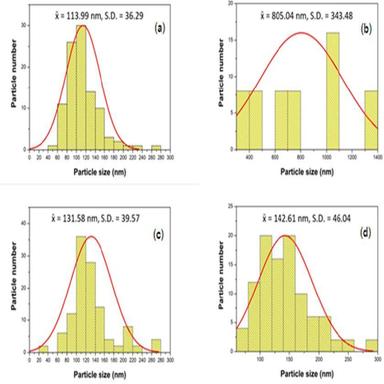
Particle size histograms of (a) CSS An 500 5; (c) CSS An 900 5; (c) CSS An 900 5 and (d) CSS An 700 10.